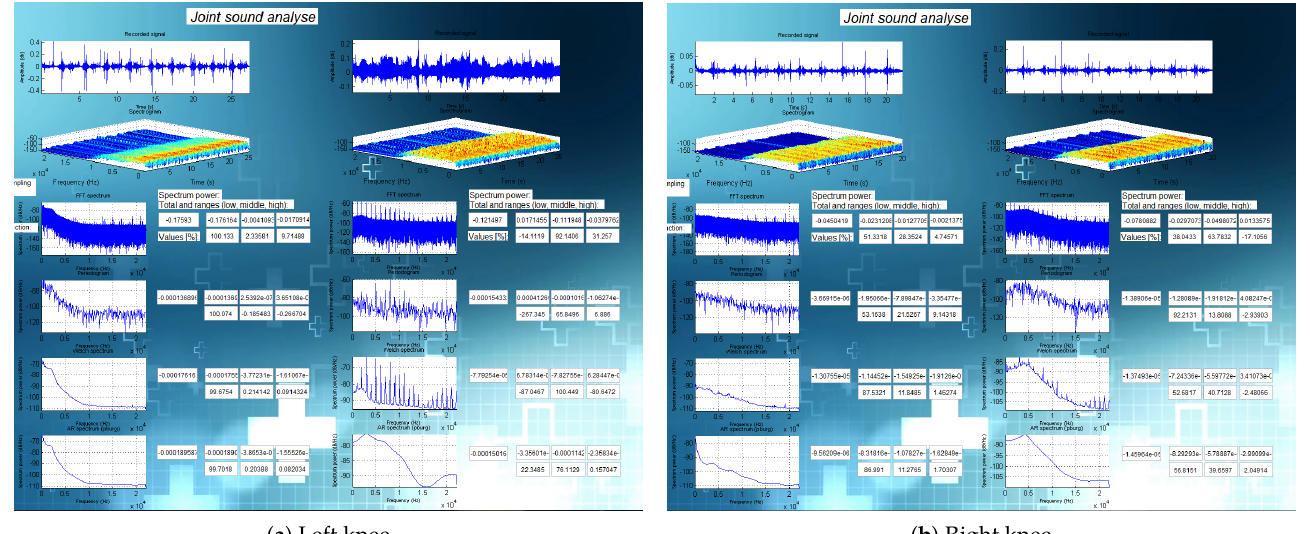
4. gender: Male, age: 36, height: 180 cm, body mass: 92 kg, lifestyle: Sedentary-standing, physical condition: Average, knee injuries: Multiple contusions of the knee related to off-road riding on a motorcycle, other remarks: Irregular physical activity (Figure A4);